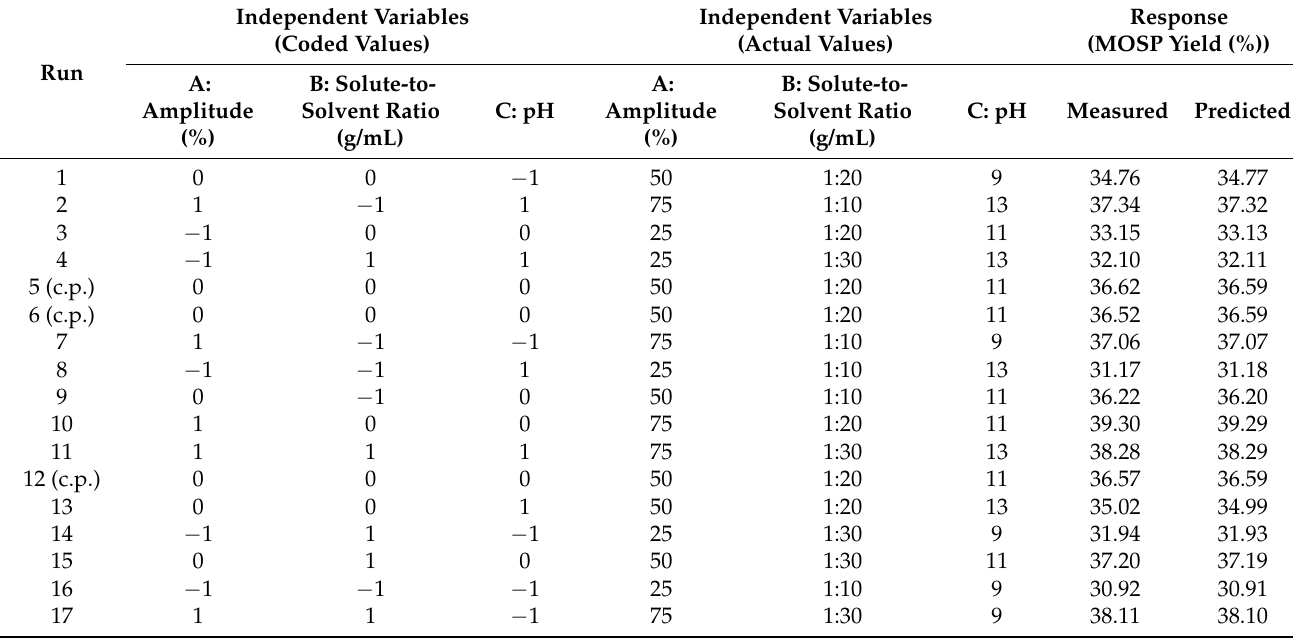
Table 1. Central composite design representing the experimental trials along with M. oleifera seed protein (MOSP) yield.